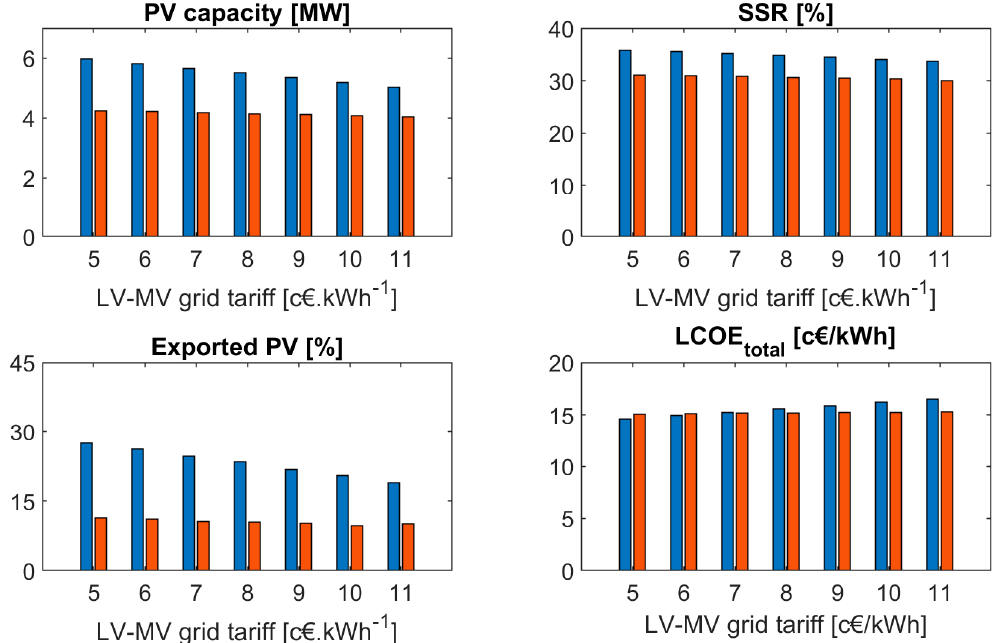
Figure 11. Comparing scenarios 2a (in blue) and 2b (in orange) regarding the installed PV capacity (upper left plot), the achieved SSR (upper right plot), the percentage of exported PV generation (bottom left plot), and the LCOE total (bottom right plot).